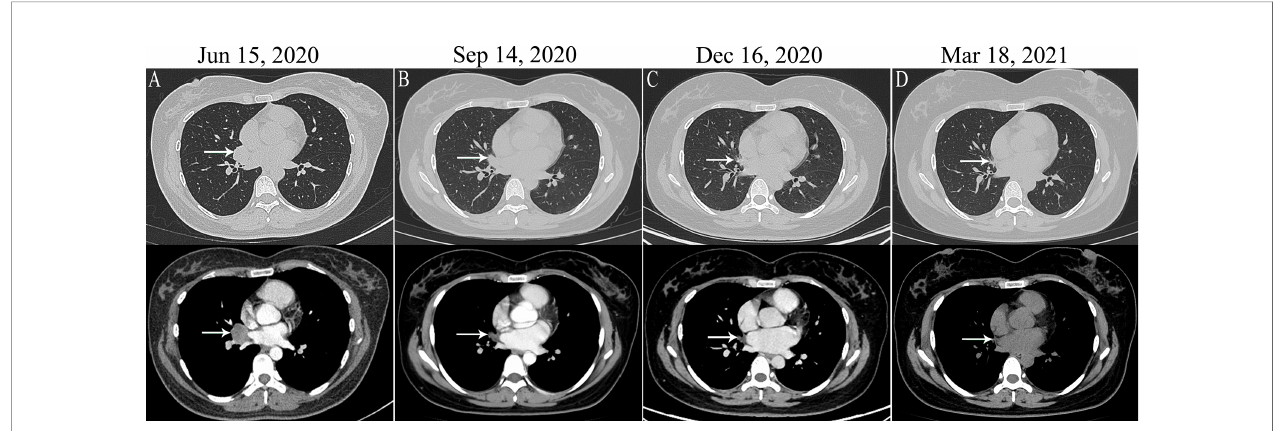
FIGURE 1 | The lung target lesion on CT (white arrow). (A) Computed tomography (CT) scan showed a 2.7 cm×2.5 cm mass in the hilum of the right lung before treatment. (B) the imaging of lung target lesion after 1 month of alectinib treatment (1.4 cm × 1.1 cm lesions). (C) the imaging of lung target lesion after 4 months of alectinib treatment (1.2 cm × 1.0 cm lesions); (D) the imaging of lung target lesion after 7 months of alectinib treatment (1.1 cm × 0.7 cm